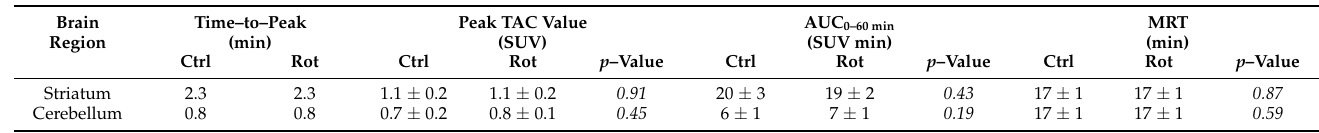
Figure 2. Mean time–activity curves of standardised uptake values (SUV; black lines) and cumula- tive area under the curves (AUC; grey lines) of control ( n = 7, dashed lines, triangles) and rotenone– treated ( n = 6, solid lines, circles) C57BL/6JRj mice. ( A ) striatum and ( B ) cerebellum, mean ± SD. Table 4. Non–compartmental pharmaokinetic parameters derived from the time–activity curves of [ 18 F]FLUDA in target and reference regions in healthy (ctrl, n = 7) and rotenone–treated (rot, n = 6) C57BL/6JRj mice.